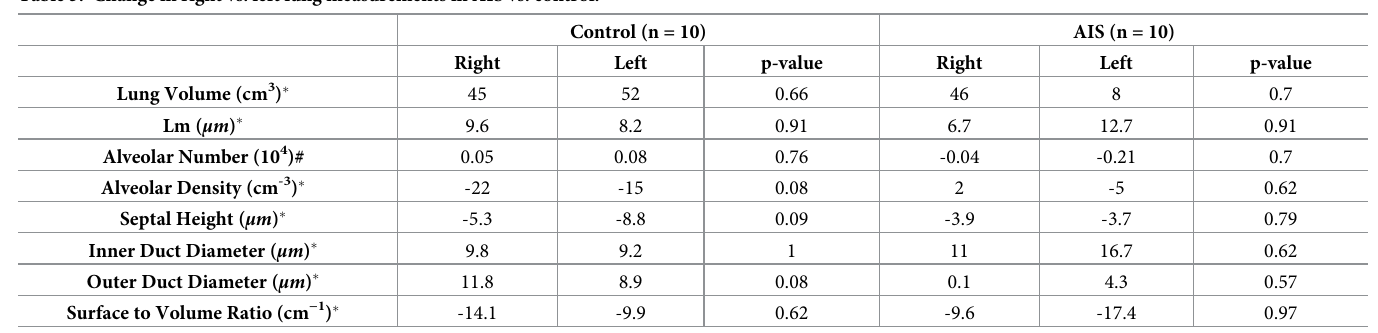
Table 5. Change in right vs. left lung measurements in AIS vs.